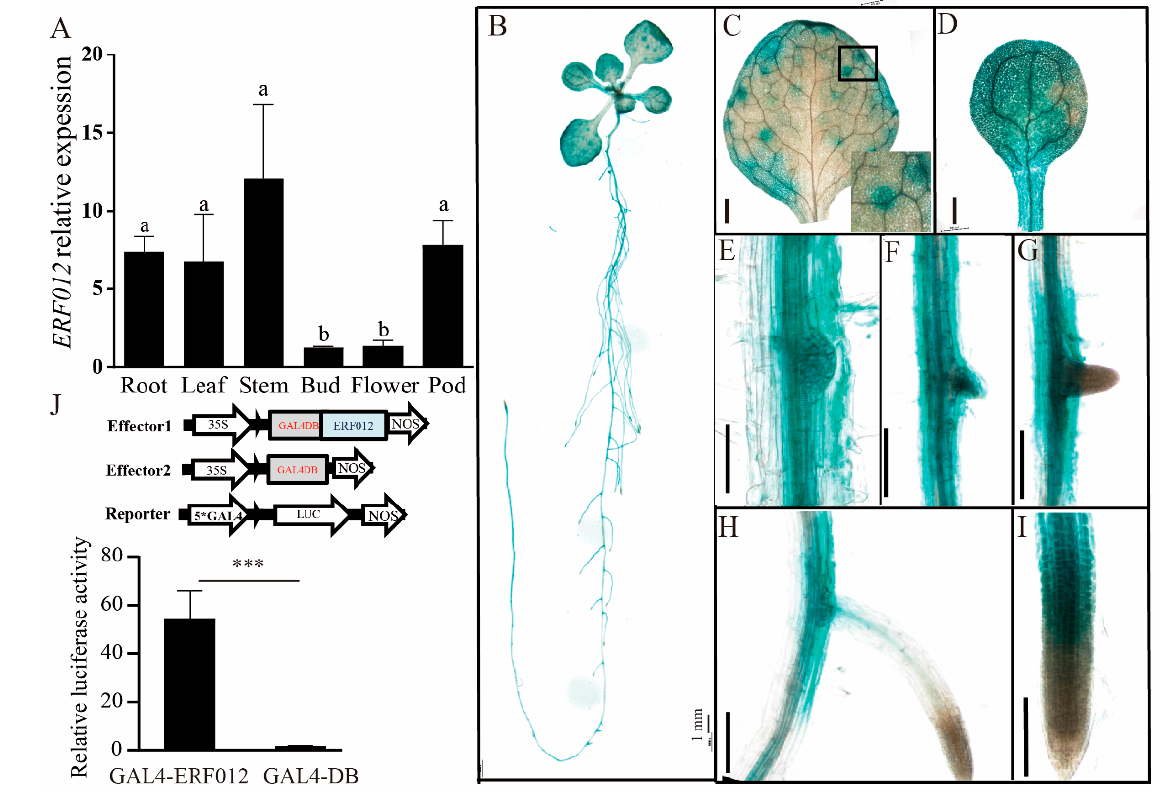
Figure 1. Tissue expression and transactivation assay of Arabidopsis ERF012 . ( A ) Expression levels of ERF012 in different tissues. Thirty-five-day-old Arabidopsis was used for qRT-PCR analysis. Letters indicate significant differences between different tissues: Duncan’s test ( p < 0.05). ( B – I ) Expression pattern analysis of ERF012 in seedlings. Twelve-day-old seedling expressing p ERF012 :GUS was used. A close-up was indicated by a black frame in ( C ). Scale bar = 100 μ m in ( C – I ). ( J ) Transactivation assay of ERF012 genes in protoplast. GAL4-ERF012 is the effector and GAL4-LUC is the reporter. GAL4-DB is the control. The values are means ± SD, n = 5. Asterisks indicate significant differences between different treatments: Student’s t -test, *** p <